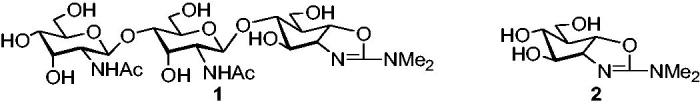
Structures of allosamidin 1 and allosamizoline 2.